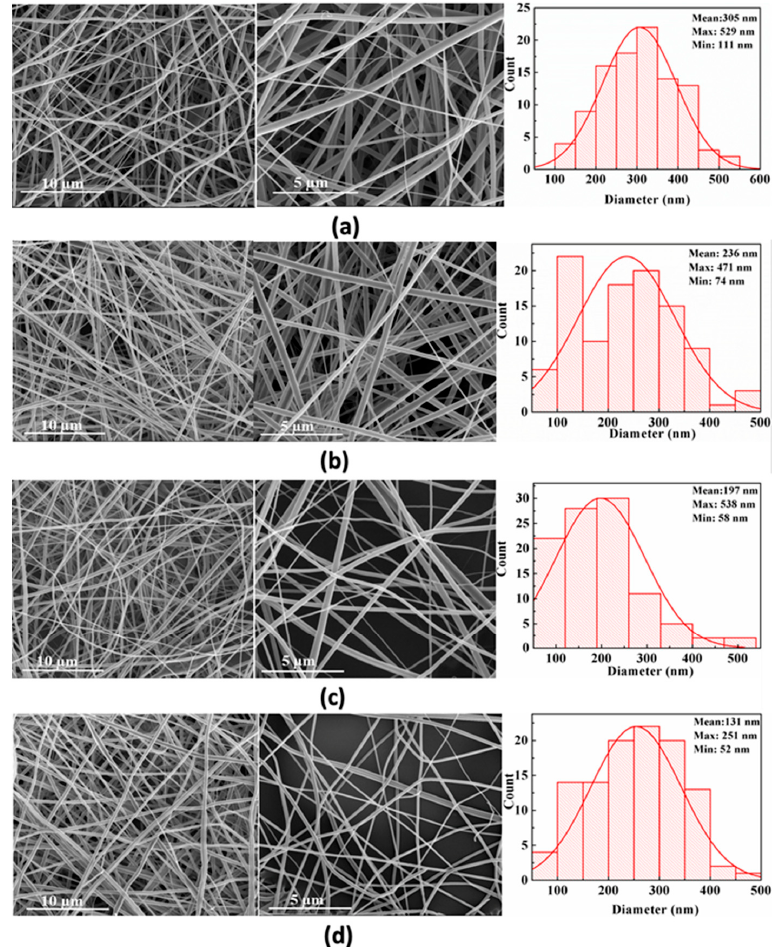
Figure 2. The representative FE-SEM images and corresponding fiber diameter distribution of electrospun fibers: ( a ) PVP; ( b ) PVP/CNC-2%; ( c ) PVP/CNC-4%; and ( d ) PVP/CNC-4%/AgNO 3 -0.34%. Each subfigure shows spun fibers at 10 μ m and 5 μ m resolution levels, and diameter distribution (bar chart).